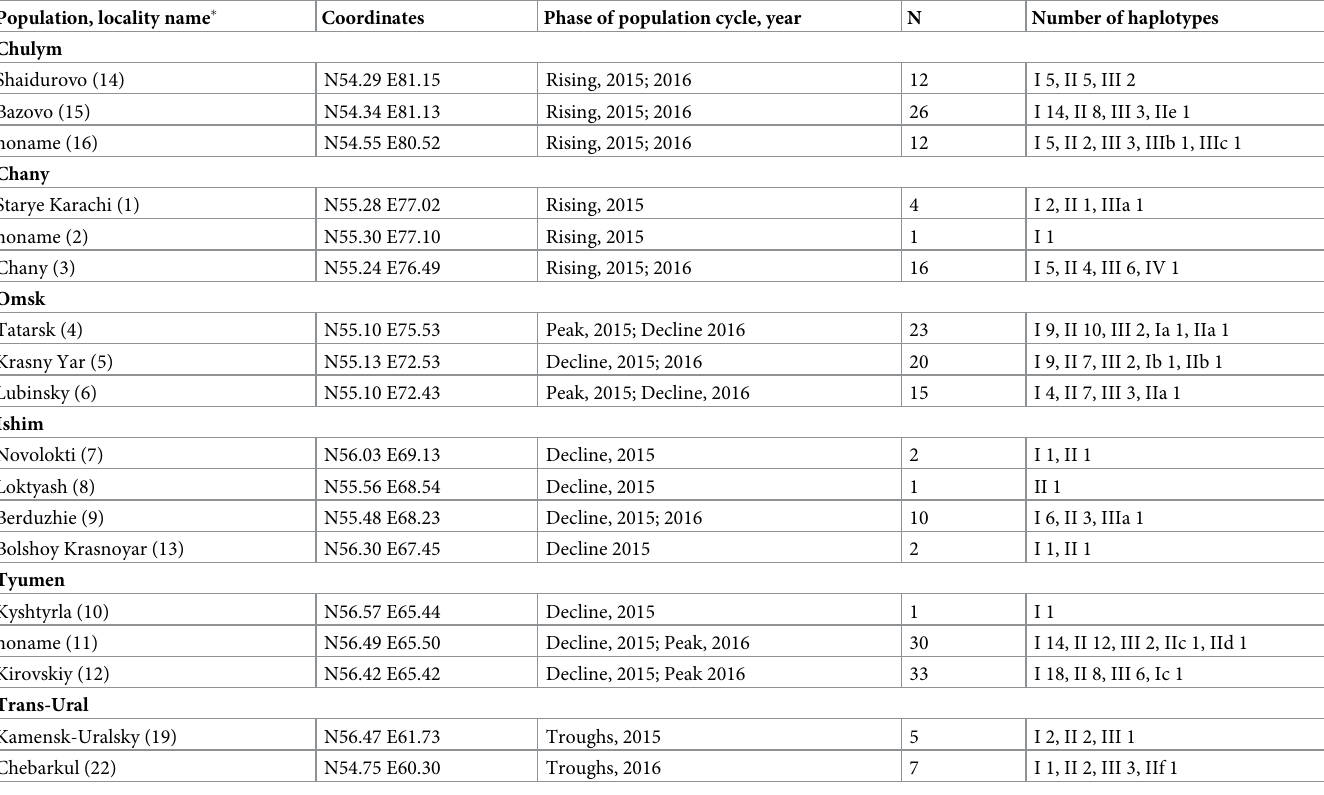
Footnotes: � Number in brackets is an internal sample